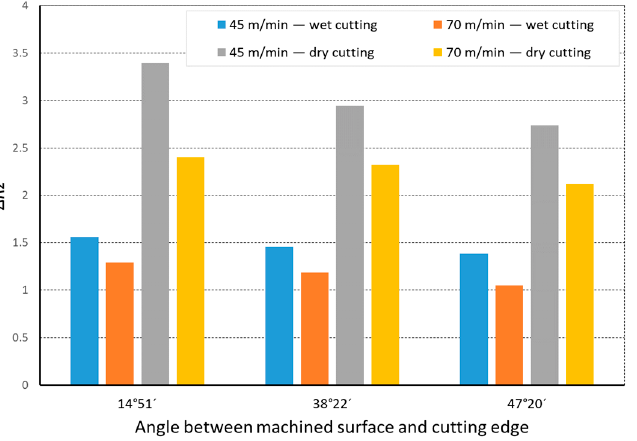
Figure 15. The impact of angle between the machined surface and cutting edge on ratio ∆ Rz of the average measured surface roughness height to the theoretical surface roughness Rz to for a curvilinear track and 36 HRC.